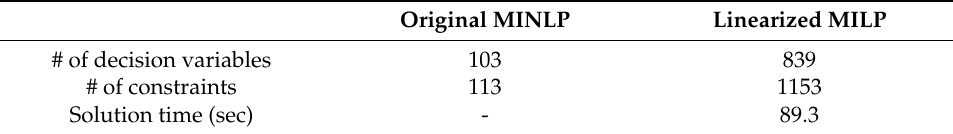
Table 6. Dimension of original MINLP and linearized MILP models.